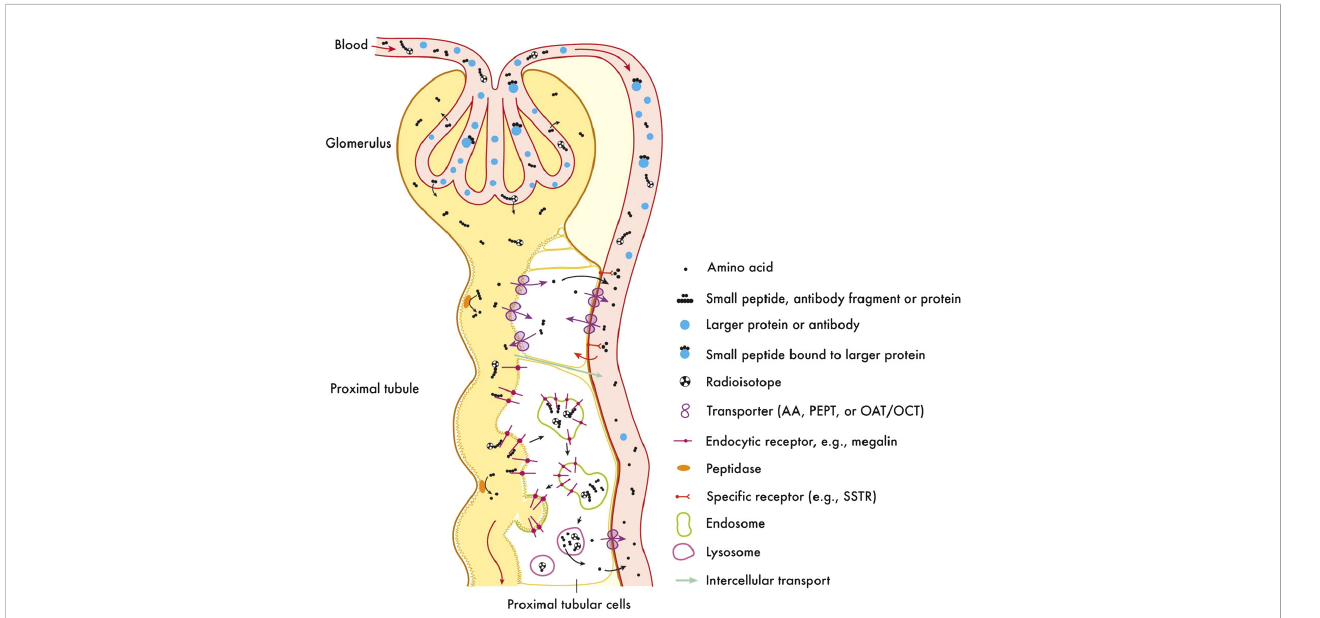
FIGURE 3 Clearance and re-absorption of peptides and small molecules in kidney. This research was originally published in (108). Copyright (2010) Journal of nuclear